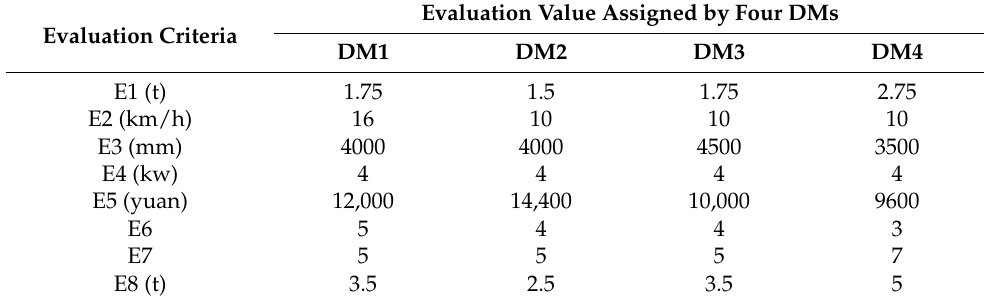
(b) Scheme Value Assessment of Evaluation Criteria on the Economy Evaluation